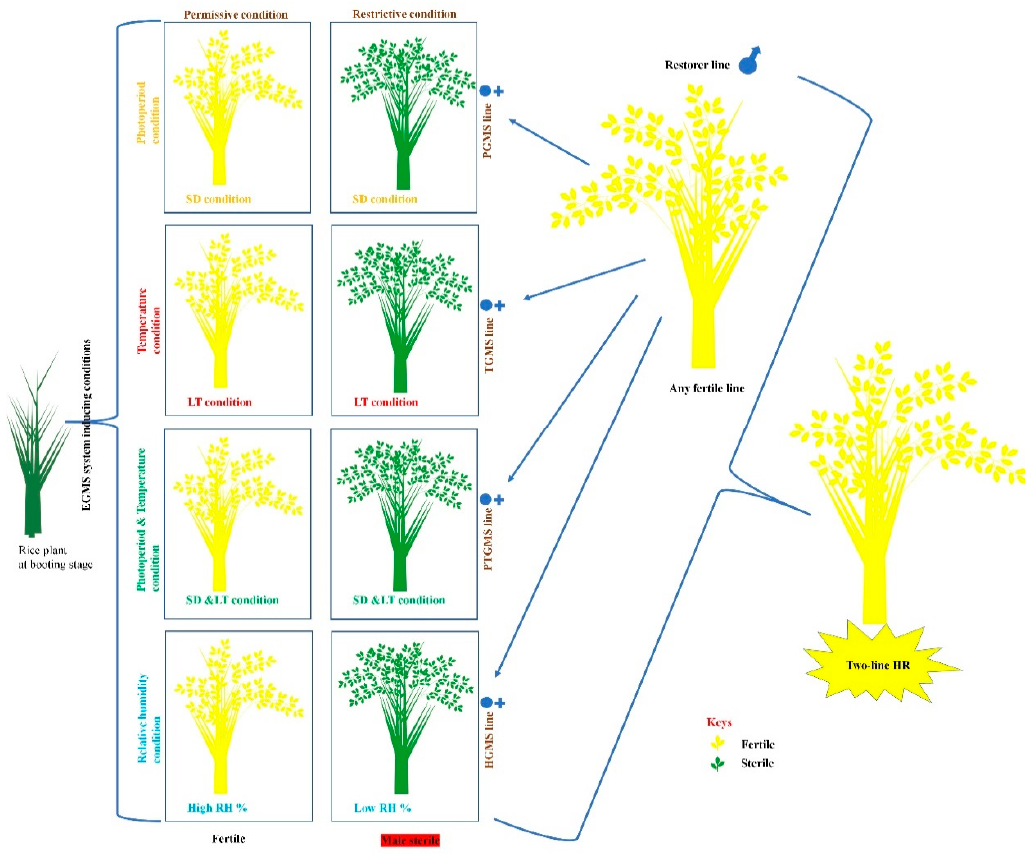
Figure 2. Two-line hybrid-rice technology.